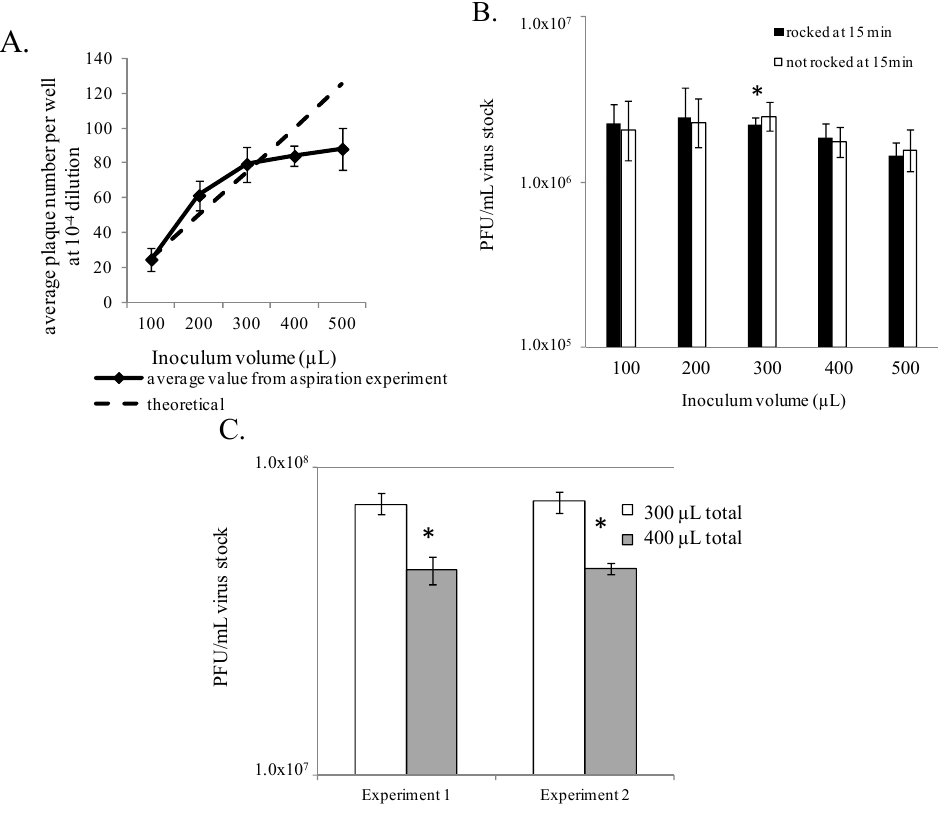
Figure 5. Evaluation of optimal inoculum volume. ( A ) EBOV titers may be reduced if the inoculum volume is too large. ( B ) 300  L inoculum volume appears optimal for EBOV plaque formation. * indicates a significant difference in value between the 300 µL and the 500 µL conditions, where plates were rocked during incubation. Each bar represents six replicates (two experiments). ( C ) 300  L inoculum volume appears optimal for MARV plaque formation. * indicates comparisons between 300 and 400 µL for Experiments 1